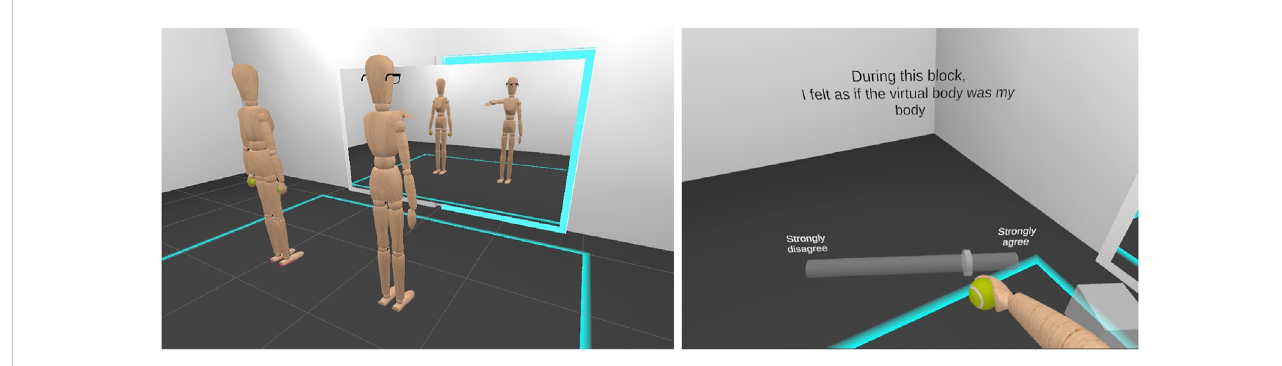
FIGURE 1 (Left) Experimental scene: the participant ’ s avatar and the virtual experimenter, showing the movement to perform. (Right) Questionnaire in VR: participants interacting through their avatars with virtual sliders and buttons to answer the